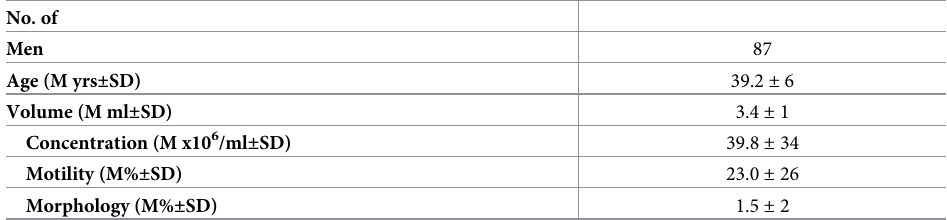
Table 1. Characteristics of non-azoospermic men and specimens screened by FISH aneuploidy. No.